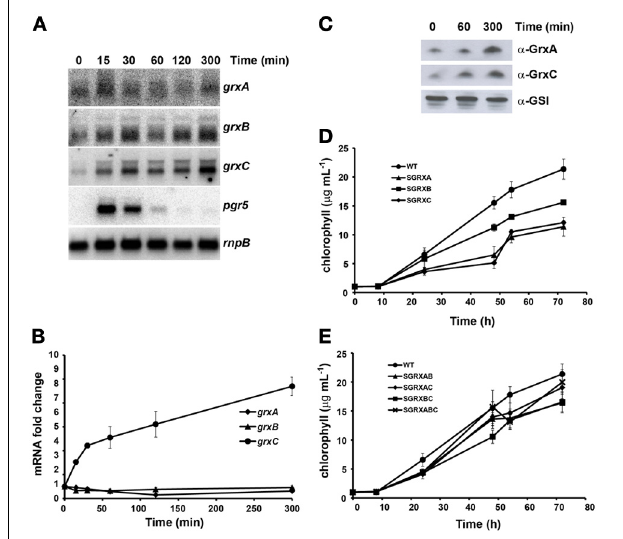
FIGURE 3 | Effect of high light on glutaredoxin gene expression and growth. (A) Northern blot analysis of grxA , grxB , grxC , and pgr5 expression in response to a shift from 50 to 500 μ E · m − 2 · s − 1 light intensity. Total RNA was isolated from exponentially growing WT cells at the indicated times after the shift. The filter was hybridized with grxA , grxB , grxC, and pgr5 probes and subsequently stripped and re-hybridized with an rnpB probe as a control. (B) Quantification of relative mRNA levels of grxA , grxB, and grxC in response to a shift from 50 to 500 μ E · m − 2 · s − 1 light intensity. Radioactive signals were quantified and normalized to the rnpB signal. Plots of relative mRNA levels vs. time were drawn; data represent average of 3 independent experiments and error bars represent SE. grxA ( (cid:4) ), grxB ( (cid:2) ), and grxC ( • ). (C) Western blot analysis of GrxA and GrxC levels in response to a shift from 50 to 500 μ E · m − 2 · s − 1 . WT cells were grown in BG11C medium and samples were collected at the indicated times after the shift. 15 μ g of total protein from soluble extracts were separated by 15% SDS-PAGE and subjected to western blot to detect GrxA, GrxC, and GSI. (D) Growth of glutaredoxin single mutants strains after a shift to high light. WT ( • ), SGRXA ( (cid:2) ), SGRXB ( (cid:3) ), SGRXC ( (cid:4) ) were grown until the exponential phase, diluted to 1 μ g chlorophyll mL − 1 and shifted to high light intensity. Growth was monitored by measuring chlorophyll content. (E) Growth of glutaredoxin double and triple